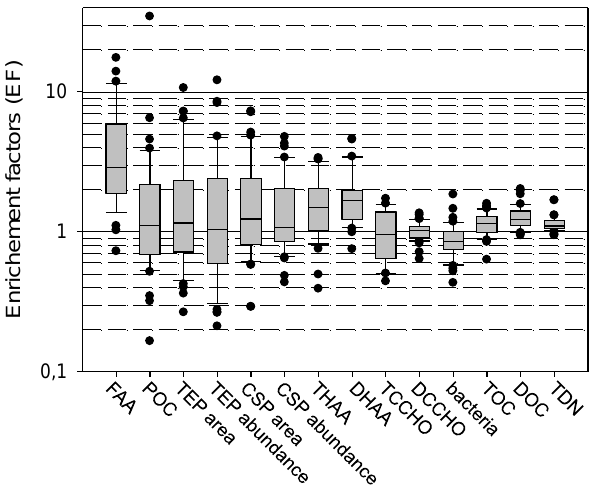
Figure 6. Box and whisker plot of enrichment factors (EFs) calcu- lated for various particulate and dissolved components during M91. Each box encloses 50% of the data with the median value of the variable displayed as a line. The bottom of the box marks the 25%, and the top the 75% limit, of data. The lines extending from the top and bottom of each box marks the 10 and 90% percentiles within the data set and the filled circles indicate the data outside of this range. For abbreviations, see text.